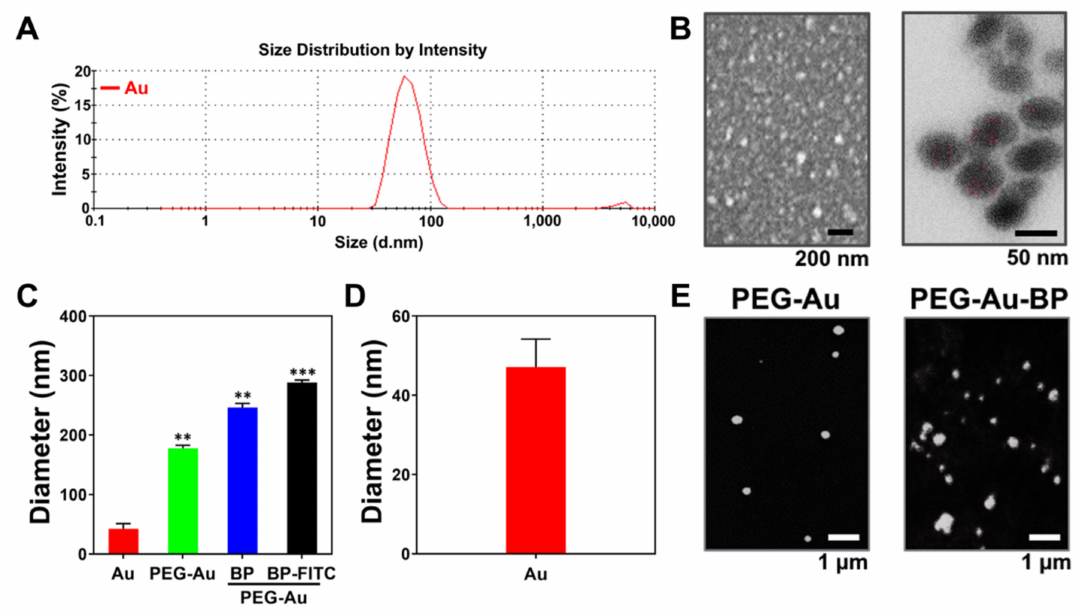
Figure 2. Identification for the size of various nanoparticles. ( A ) The size distribution intensity of Au nanoparticles was measured by DLS assay. ( B ) The left panel demonstrates the SEM image of Au nanoparticles. The scale bar equals 200 nm. The right panel displays the TEM image of Au nanoparticles. The scale bar = 50 nm. ( C ) The diameter of various nanoparticles detected by DLS assay. The size of Au, PEG-Au, PEG-Au-BP, and FITC-labeled PEG-Au-BP was demonstrated as 42.02 ± 8.95 nm, 177.5 ± 5.2, 246.27 ± 7.0, and 288.2 ± 4.2, respectively. ** p < 0.01, *** p < 0.001: compared to Au nanoparticle. ( D ) The diameter of Au nanoparticle was quantified and the average size of Au nanoparticles was 44 nm. ( E ) SEM images for the PEG-Au and PEG-Au-BP nanoparticles. The scale bar = 1 µ m. Results are presented as one of three independent